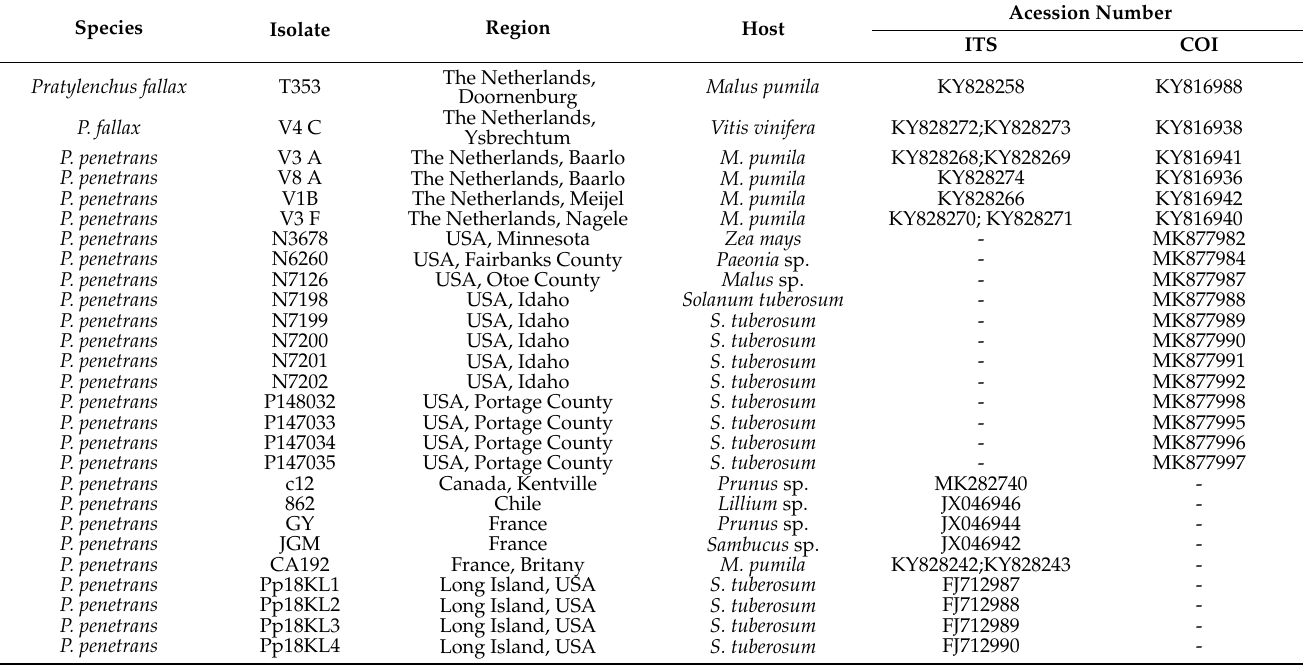
Table 7. Sequences used in this